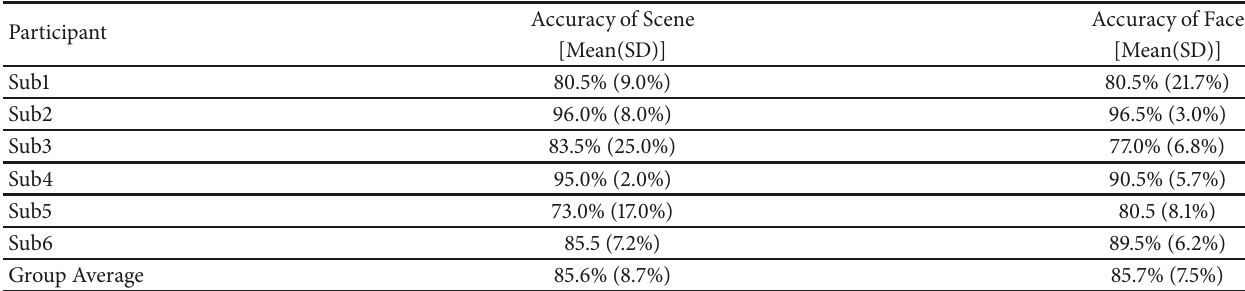
Table 4: LOBO cross-validation prediction results. Results are based on attentional state evaluation.